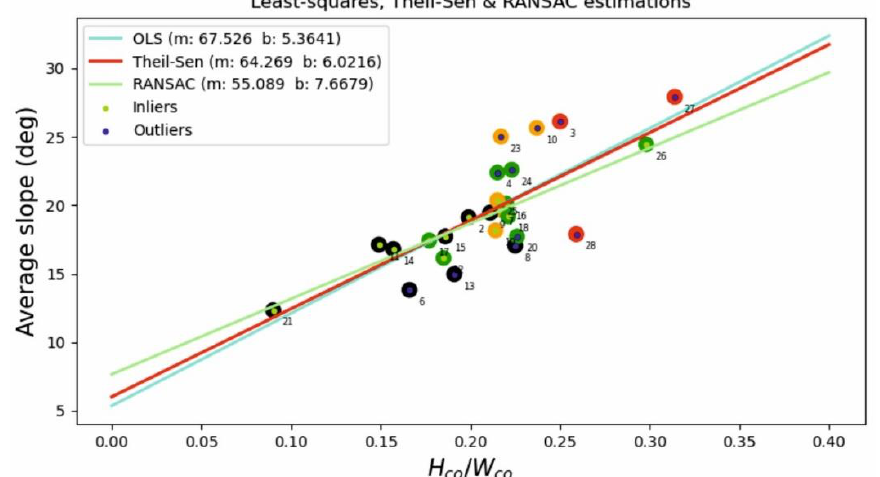
Figure 12. Modeling of average slope Wco / Hco relationship using the ordinary least squares method (OLS), Theil – Sen estimation, and RANSAC algorithm. The values indicated are the IDs of the cones.